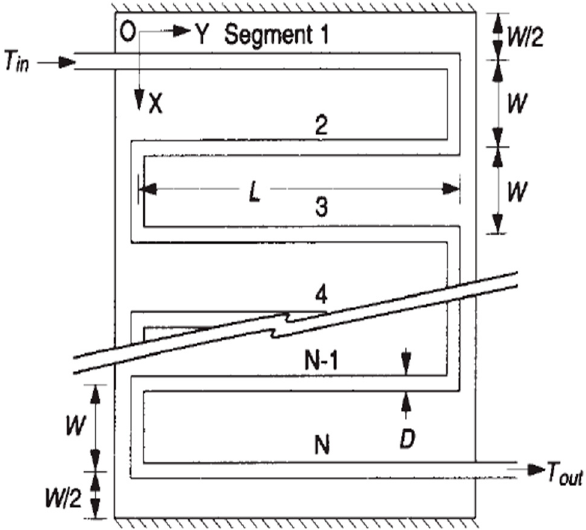
Figure 3. Schematic diagram of a flat plate thermal collector using serpentine design [32,49–55].